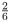
Dynamics at step one.Node 4 is selected with probability 26 and a link between 1 and 4 is revealed. If one intervention is applied, node 4 remains liquid, otherwise its equity level will decrease by one and node 4 defaults.